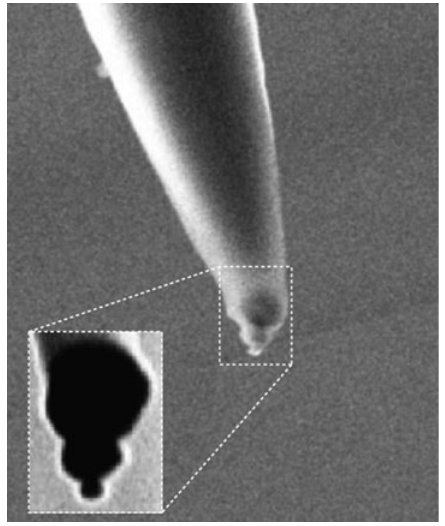
Figure 13 Self-similar colloidal gold nanosphere trimer attached to a glass fi ber tip. Adapted image reprinted with permission from Macmillan Publishers Ltd.: Nature Photonics [125] ,